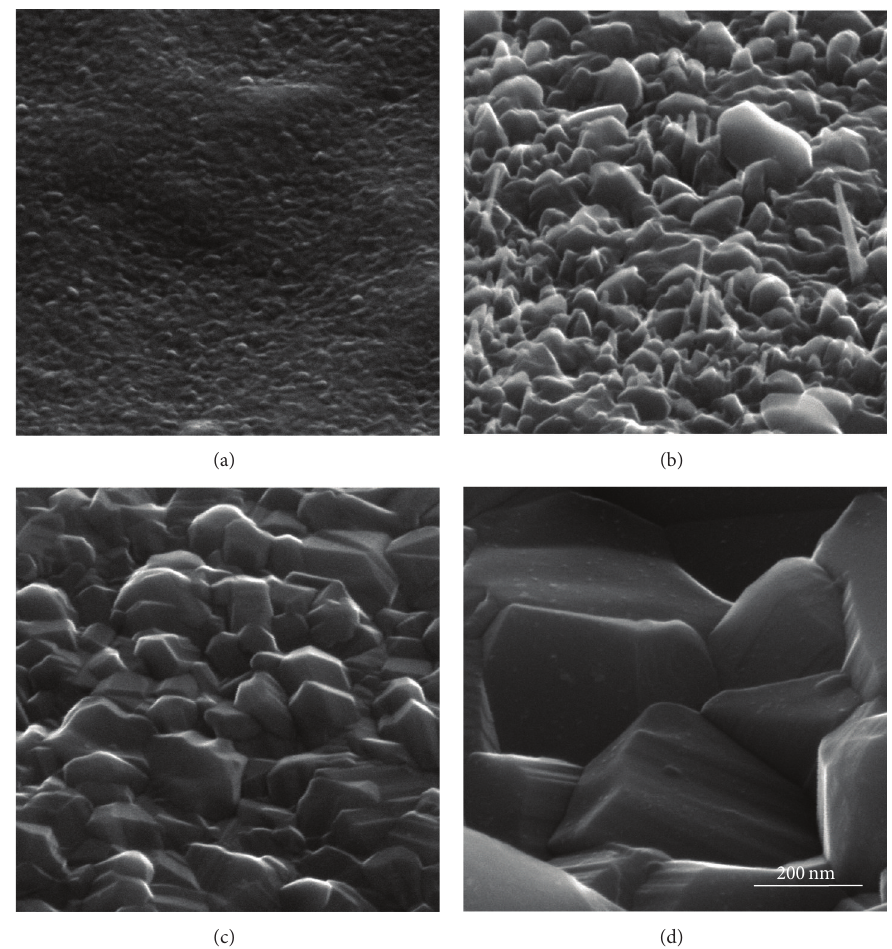
Figure 1: SEM image of the TiO 2 formed by Ti implanted into Ti foil and subsequent annealing at 400 (a), 500 (b), 600 (c), and 700 ∘ C (d) for 6 hours in oxygen atmosphere,